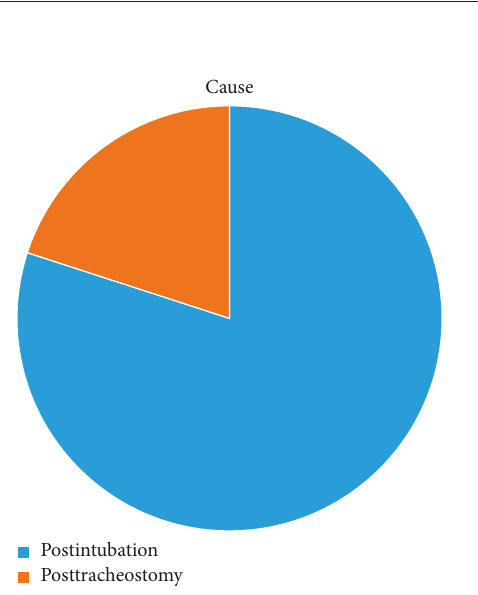
Figure 14: Main cause of